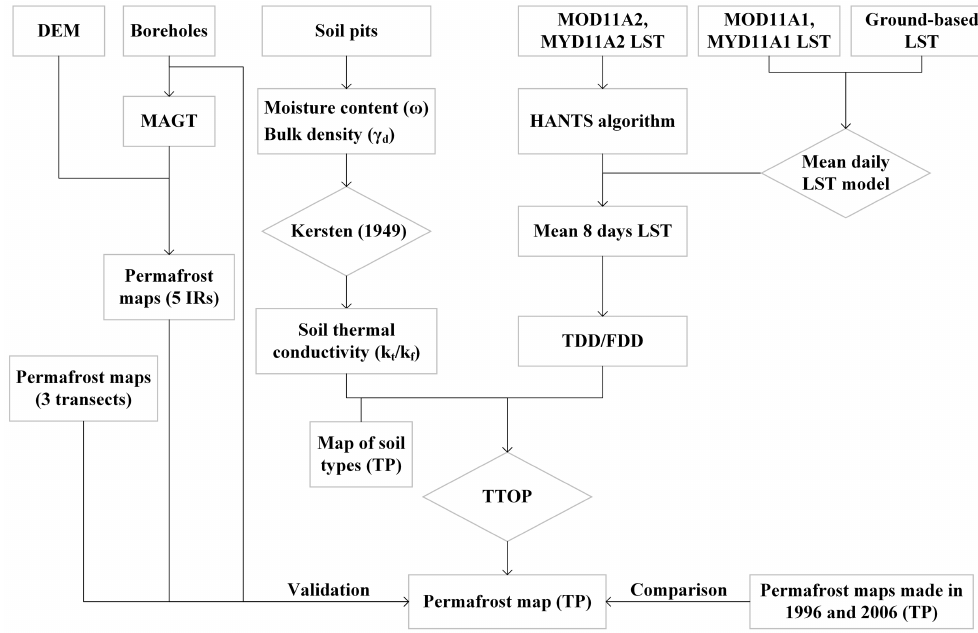
Figure 2. Flow diagram of the modelling scheme. Table 2. Soil thermal parameters of each type on the Tibetan